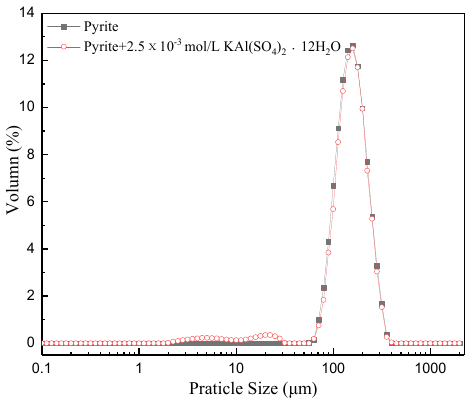
Figure 5. Effect of the presence and absence of KAl(SO 4 ) 2 · 12H 2 O on the particle size distribution of pyrite (pH = 9.0).